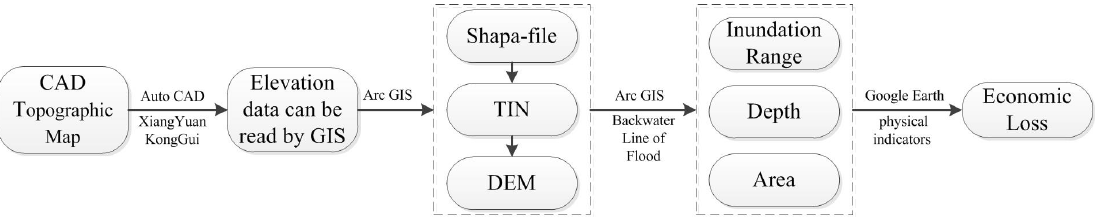
Figure 1. The flowchart to simulate the inundation range.